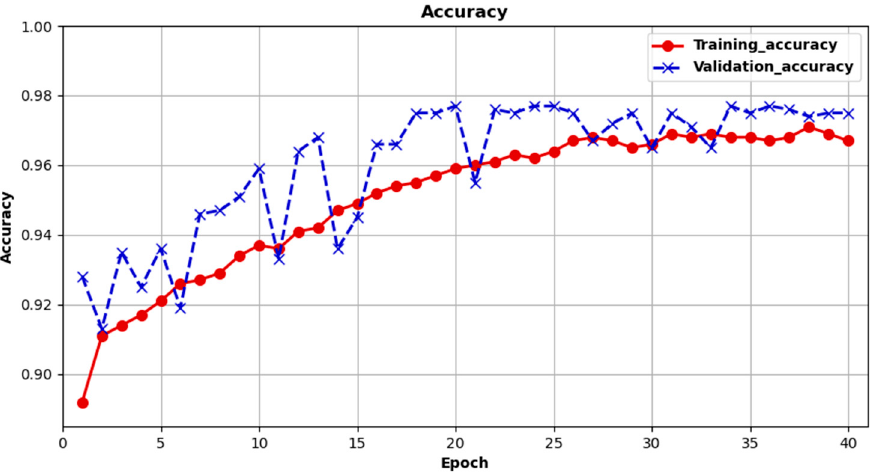
Figure 9. Identification accuracy with the number of iterations.